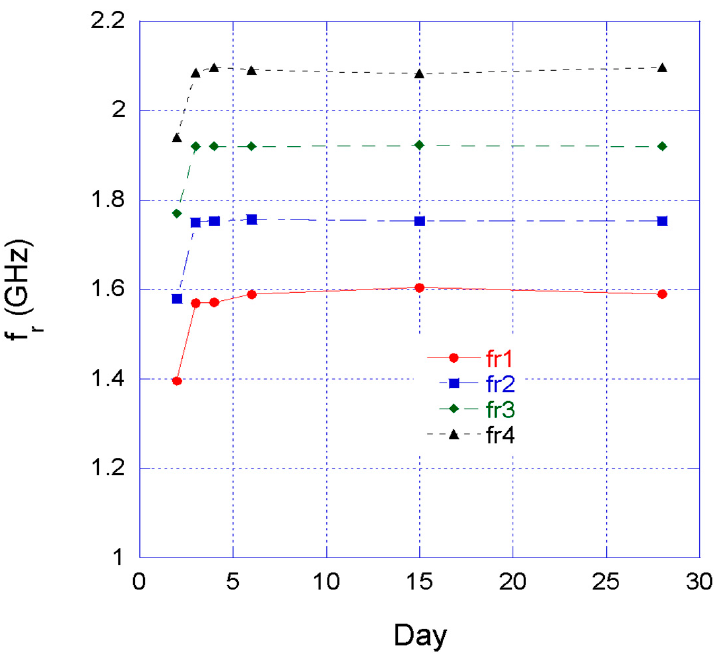
Figure 9. Computed network transmission coefficient resonance frequency during the curing phase.